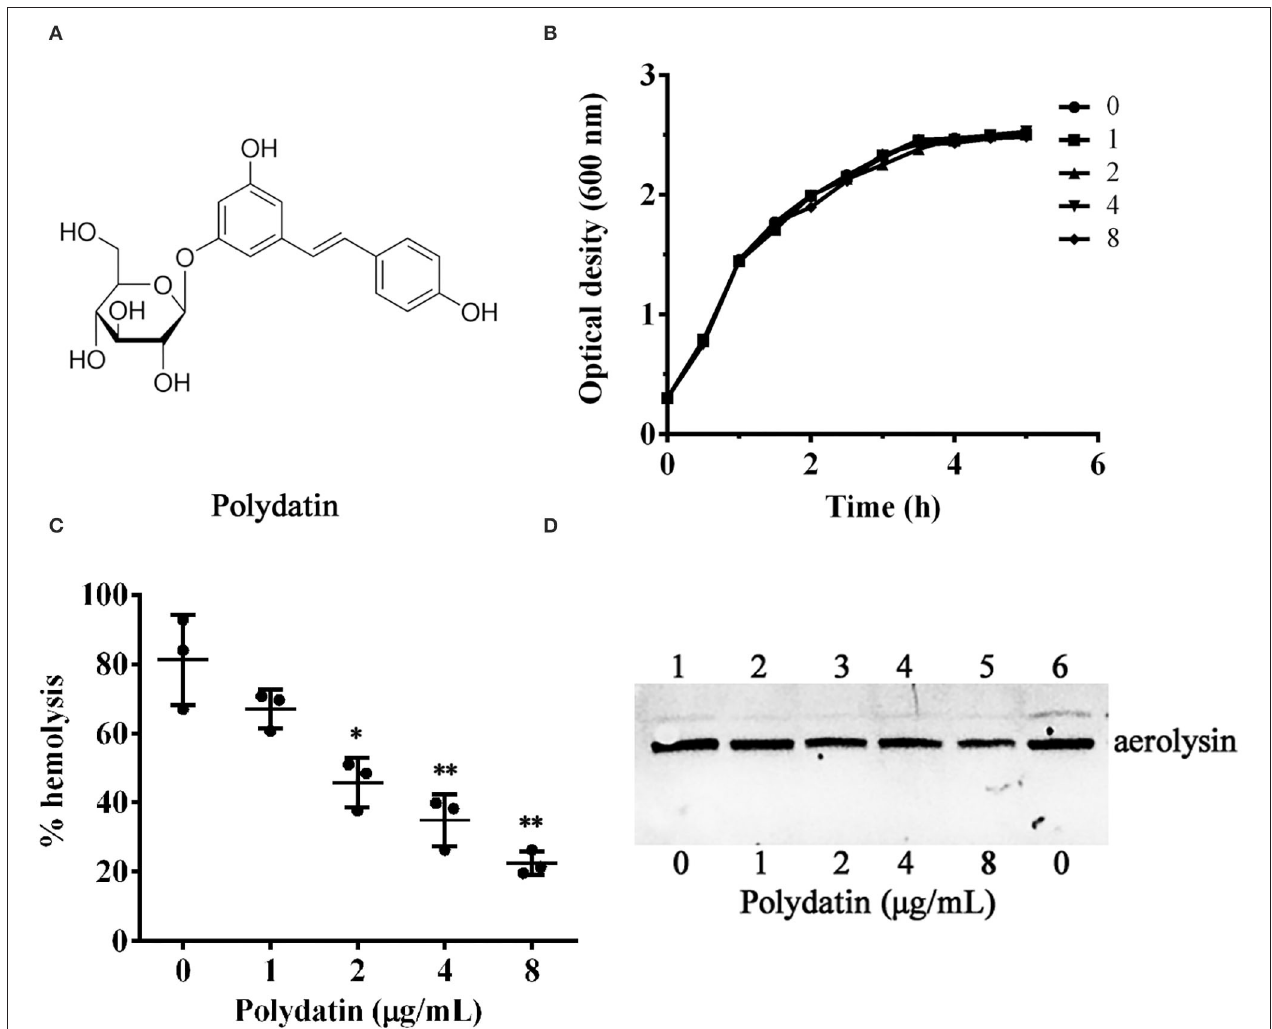
FIGURE 1 | Inhibitory effect of polydatin against aerolysin mediated hemolysis. (A) The chemical structure of polydatin. (B) Influence of different concentrations of polydatin on bacterial growth. (C) Reduction of the hemolytic activity of bacterial supernatants co-cultured with indicated concentrations of polydatin. (D) Impact of polydatin on aerolysin production in bacterial supernatants determined by western blot. Data shown in (C) are the mean ± SD of three independent assays, * represented p < 0.05, while ** was p < 0.01.